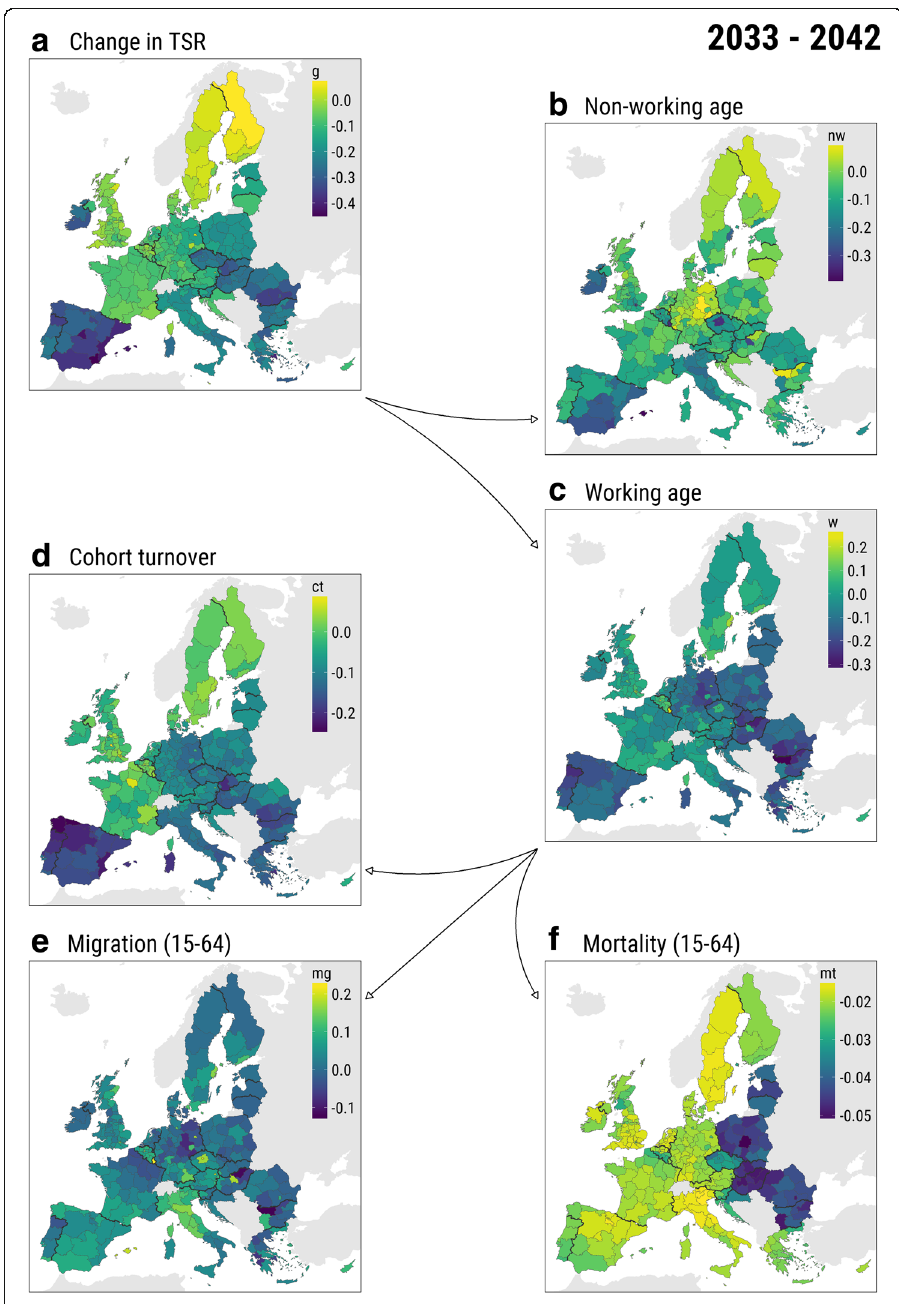
Fig. 9 Decomposition of change in TSR between 2033 and 2043. Notes : a Overall change. b Change due to dynamics in non-working-age population. c Change due to dynamics in working-age population. d Change due to cohort turnover. e Change due to migration at working ages. f Change due to mortality at working ages. Color scales are panel specific due to the big difference in variables ’